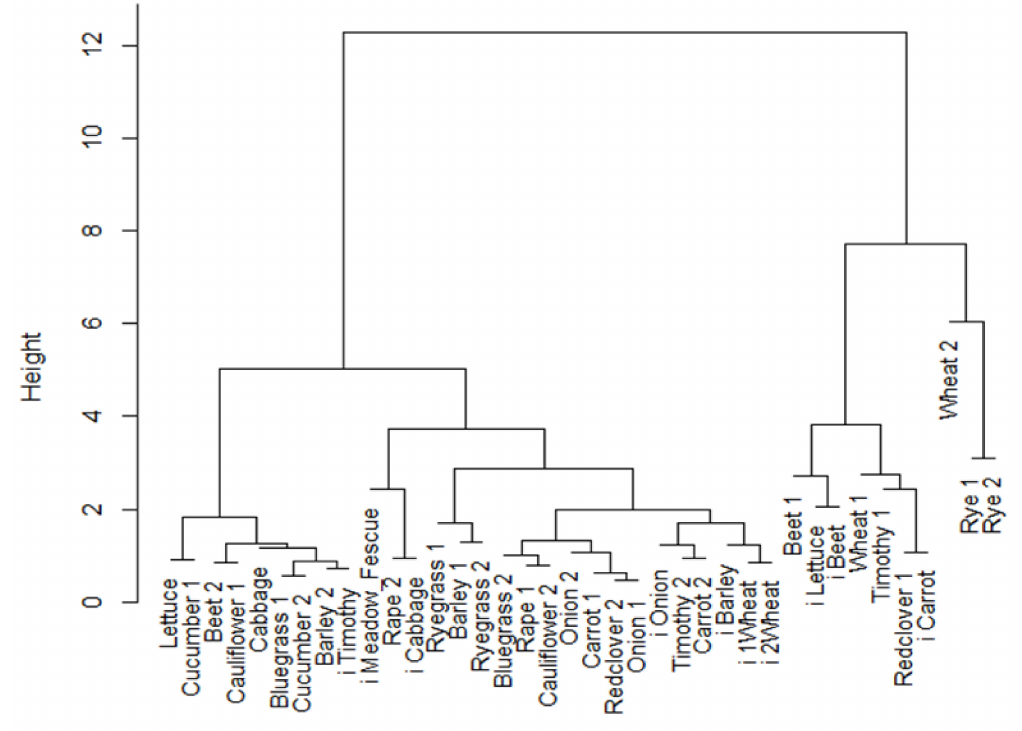
Figure 2. The dendrogram of a cluster analysis of the germination results of the seed